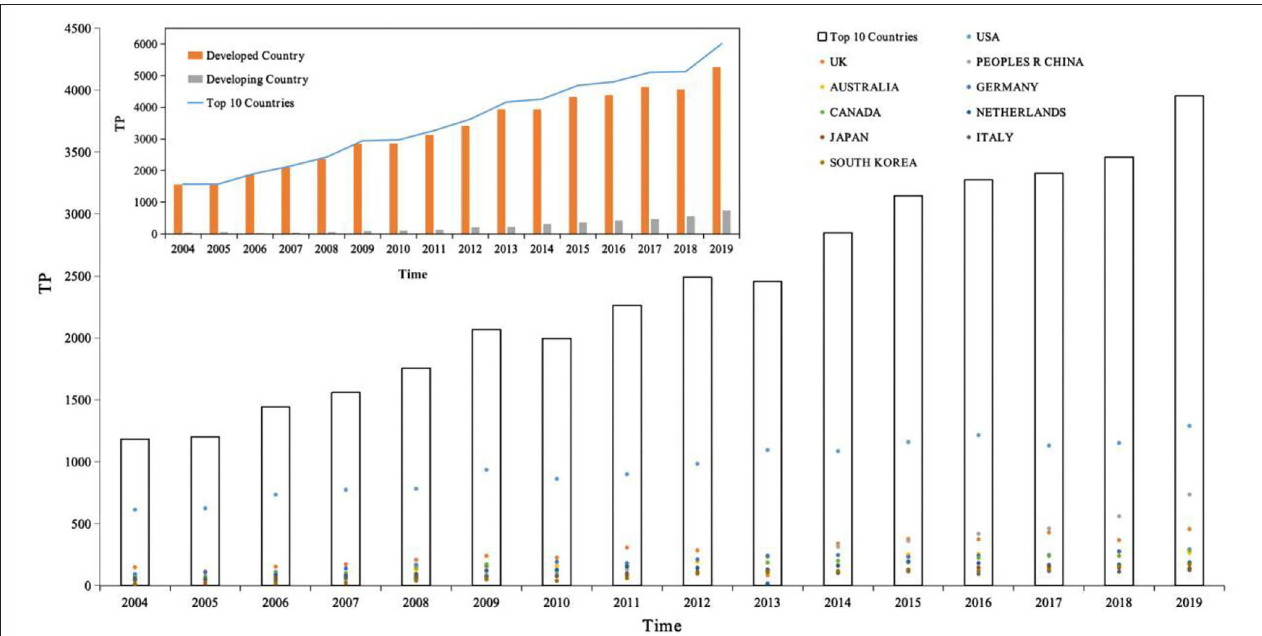
FIGURE 2 | The distribution of publications in top 10 productive countries, 2004–2019. Source: author’s calculation. National development classification criteria refer to “Human Development Report 2020” (